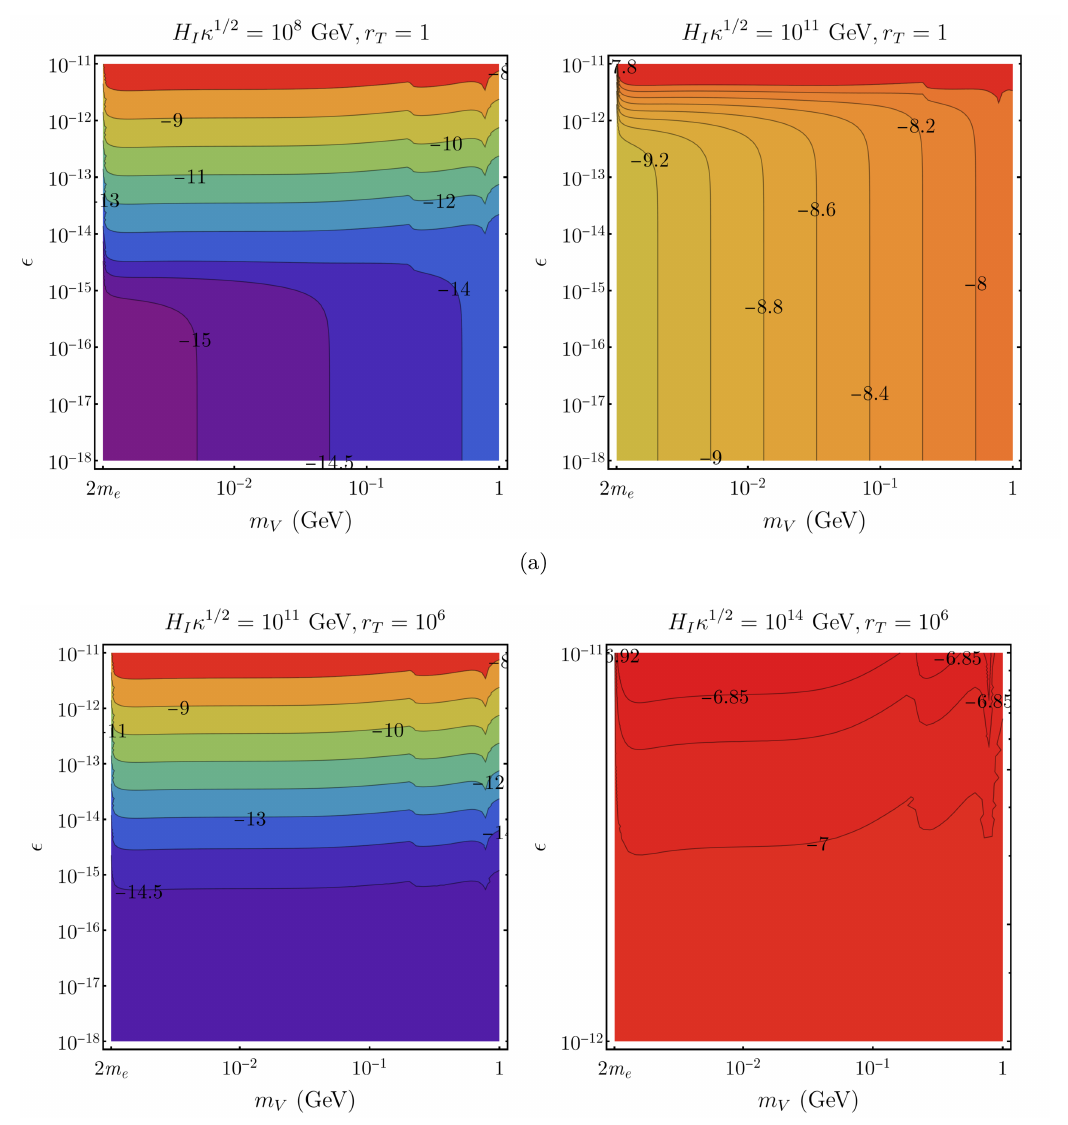
( m GeV ) contours of the dark photons produced from both gravitational and Figure 6 . log V Y V / 10 freeze-in mechanisms in (a) high reheating case r